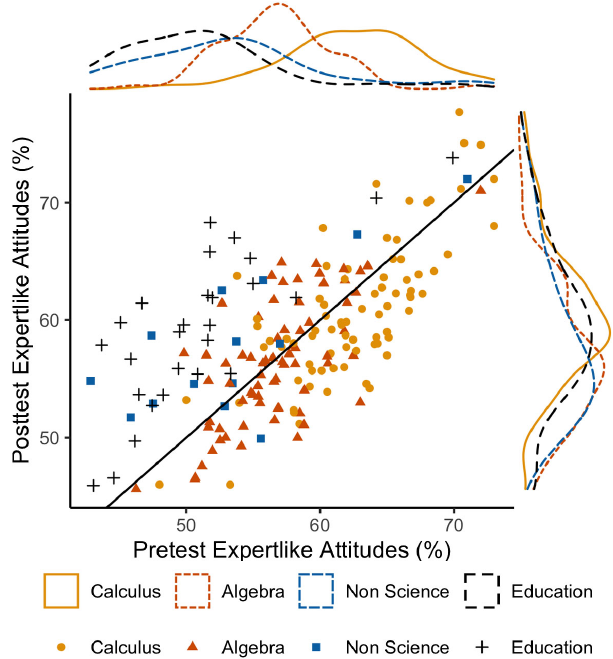
FIG. 1. Scatter and density plots for pretest and post-test attitudes in the four types of courses. Attitudes tended to start lower in courses for education and nonscience majors than in calculus- and algebra-based courses. Attitudes, however, became more expertlike in courses for education and nonscience majors to the extent that they largely overlapped with those for calculus- and algebra-based courses on the post-test. The diagonal line represents no shift from pretest to